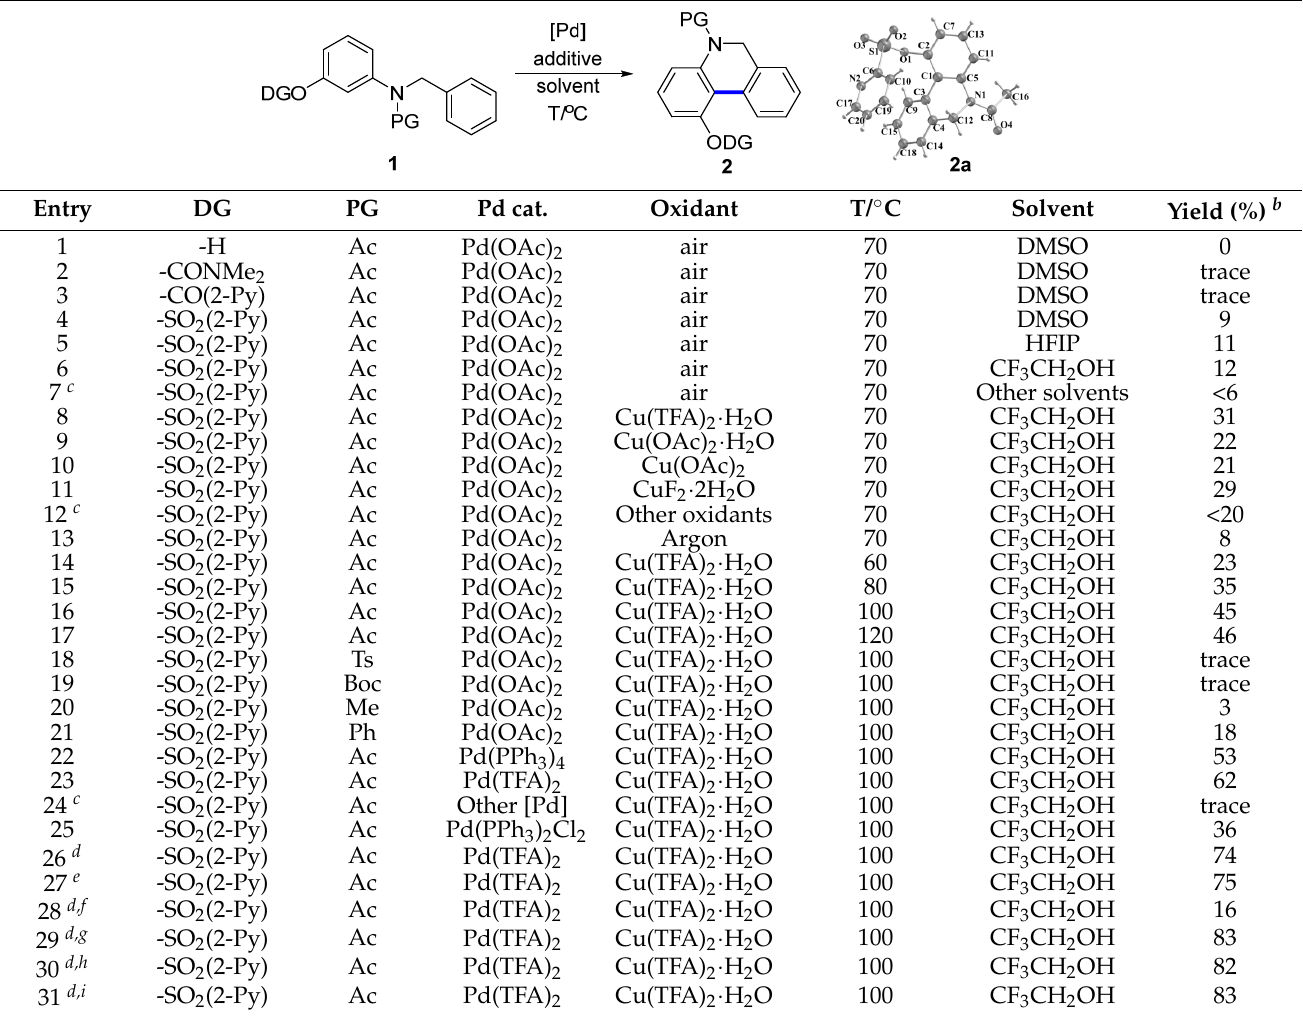
Table 1. Optimization of conditions for the synthesis of 5,6-dihydrophenanthridine a .